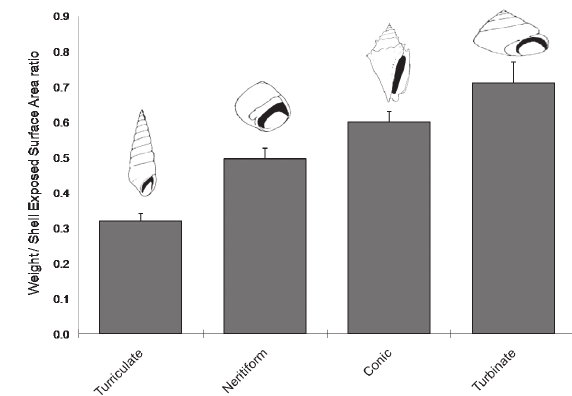
Fig . 2. – number of males, females and ovigerous females along the intertidal transect. dashed lines show the tendency of each sex in the water velocity